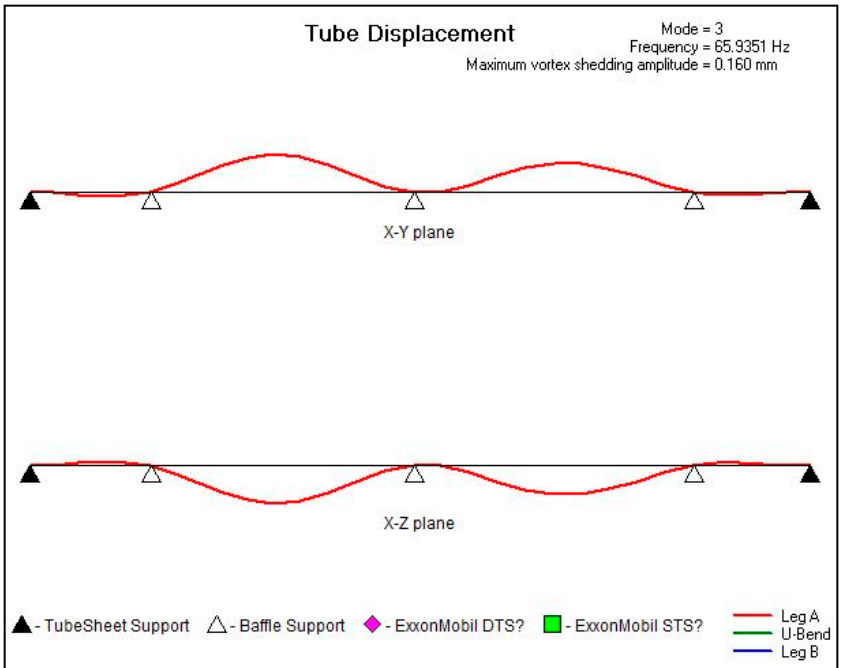
Figure 9. Tube displacement profiles of modes 3 and 4, 65.94 Hz.